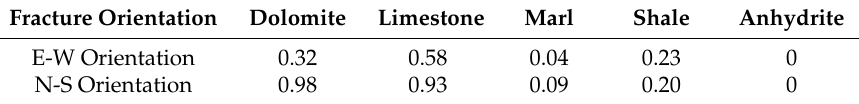
Table 4. Mean fracture density (Number of fractures /meter) as a function of facies.